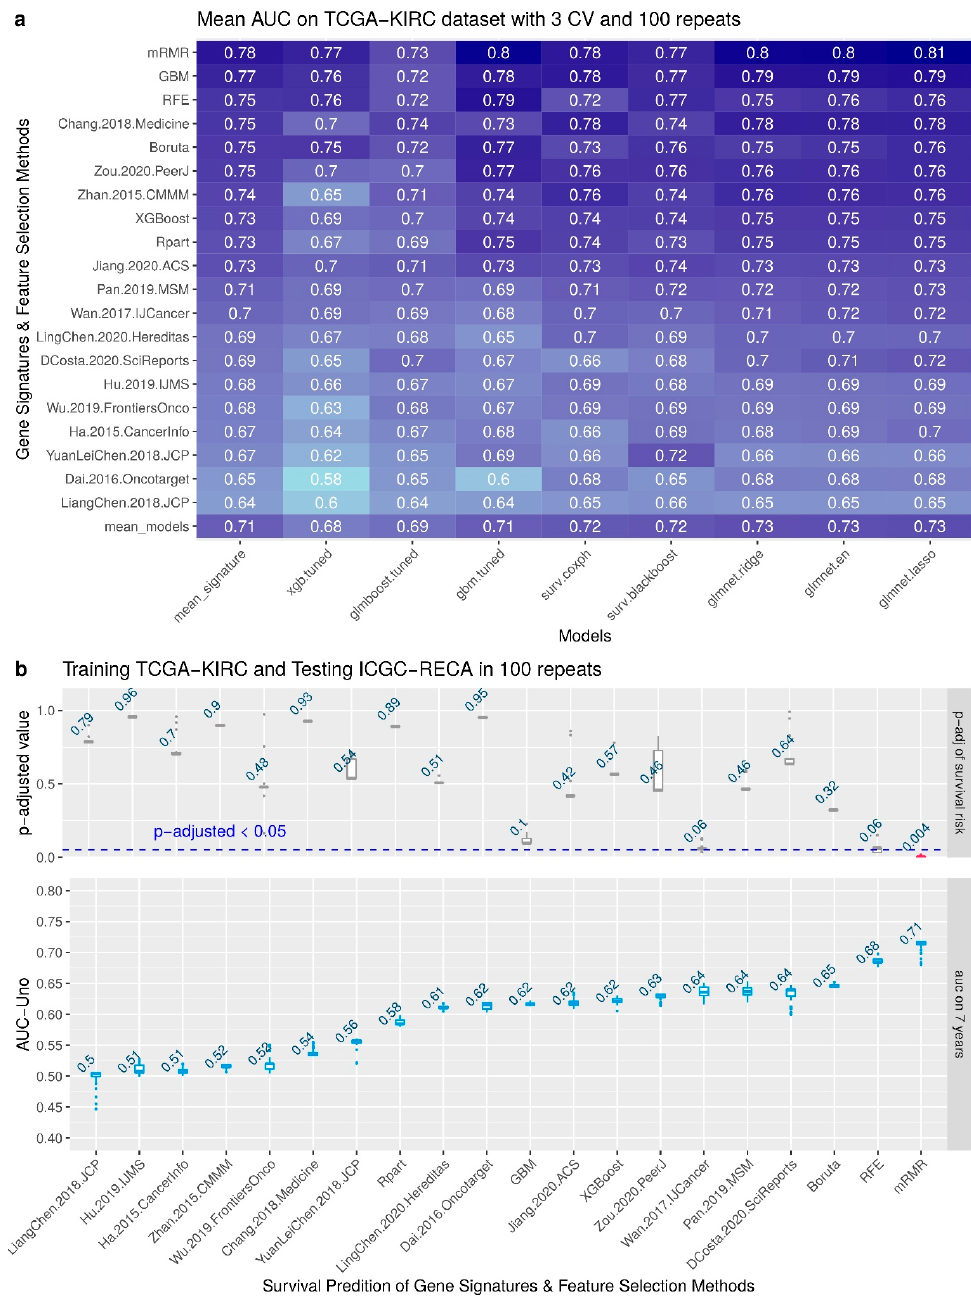
Figure 3. Benchmark with internal and external validation. ( a ) Comparison of 14 gene signatures from the literature and 6 feature selection on 8 models for survival risk, showing the predicted AUC of survival outcome in 10-years prediction. ( b ) Boxplots of results of each gene signature and feature selection for 7-year prediction.